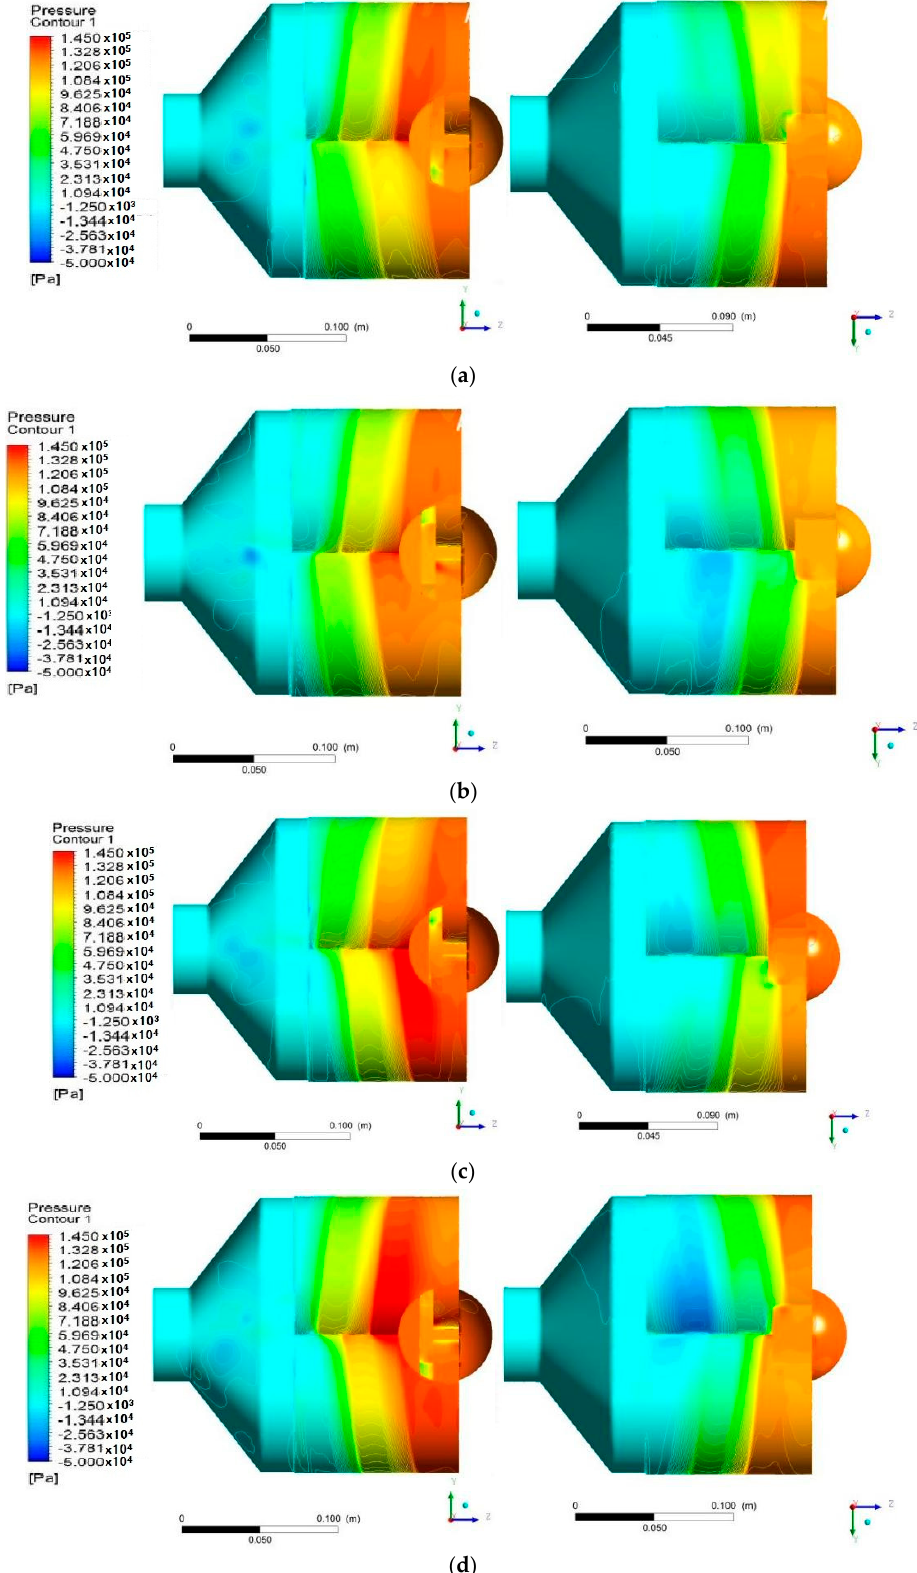
Figure 14. Surface pressure distribution of pump. ( a ) 1 / 4T cycle pressure distribution; ( b ) 1 / 2T cycle pressure distribution; ( c ) 3 / 4T cycle pressure distribution; ( d ) 1T cycle pressure distribution.